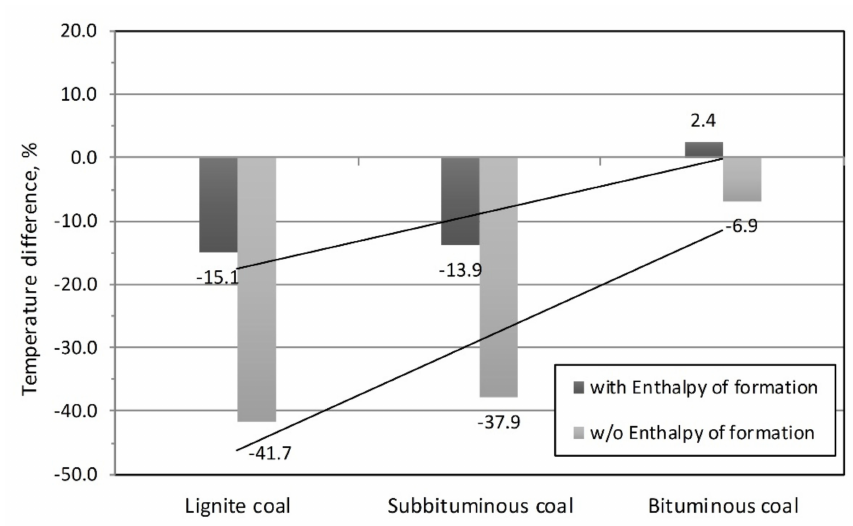
Figure 9. Difference in the calculation temperatures of coal gasification.